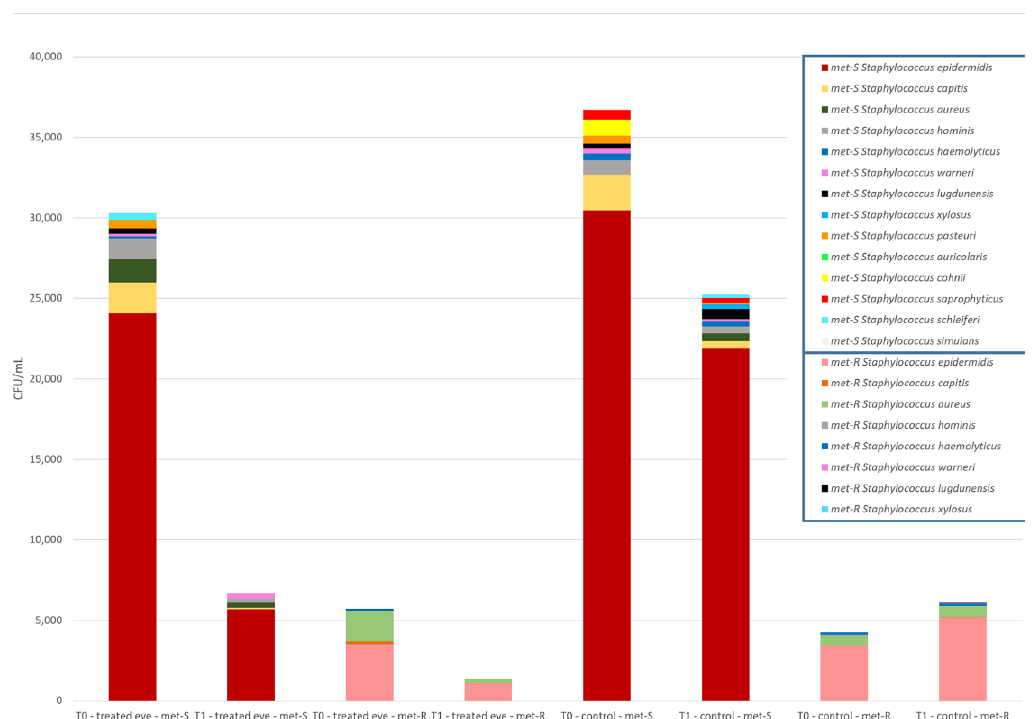
Figure 2. Distribution of methicillin-susceptible and methicillin-resistant Staphylococcus spp. cumulative loads between the treated – untreated eyes at T 0 and T 1 .